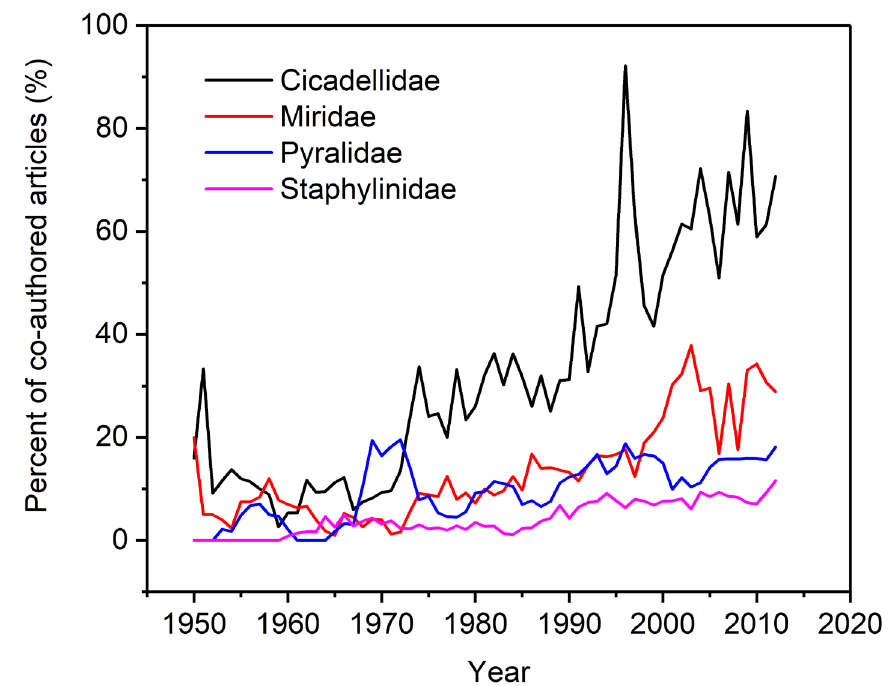
Fig. 7. Percentage of articles with co-authors from 1946 to